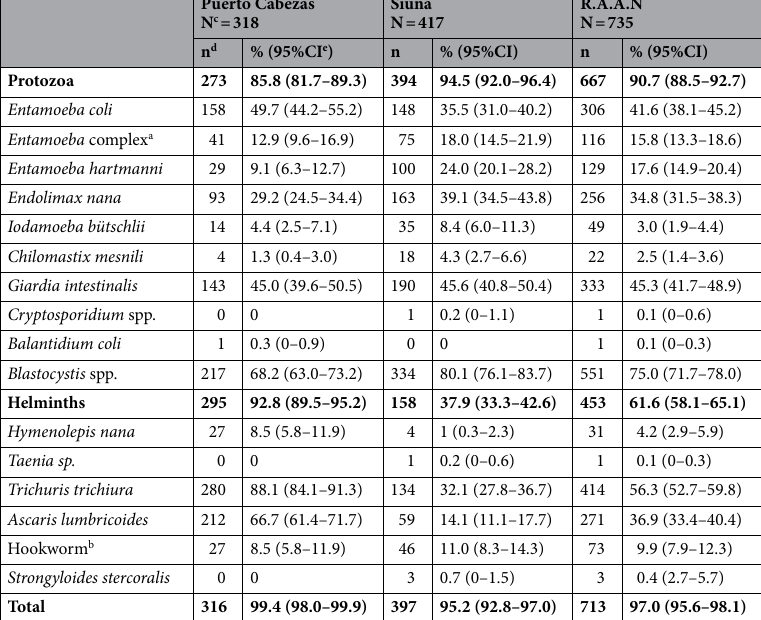
Table 1. Results of the total parasite spectrum and prevalence rates obtained in the two municipalities and in the total study in Región Autónoma Atlántico Norte (R.A.A.N.) of Nicaragua. a Entamoeba histolytica/E. dispar/E. moshkovskii. b Ancylostoma duodenale and/or Necator americanus. c Number of schoolchildren studied. d Number of schoolchildren parasitized. e 95% confidence interval. Significance values are given in bold.